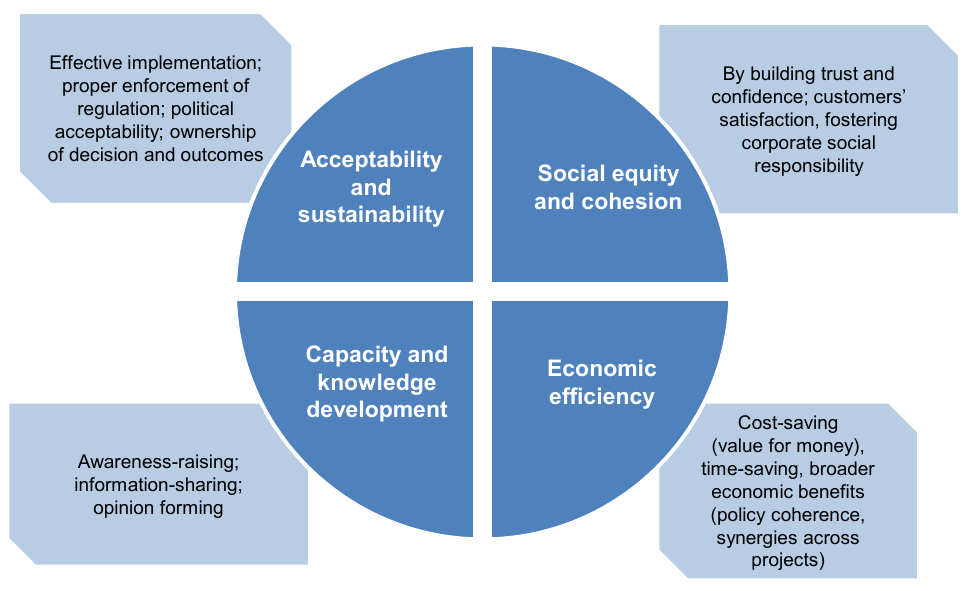
Figure 4. OECD typology of long-term benefits of stakeholder engagement in water governance [23].